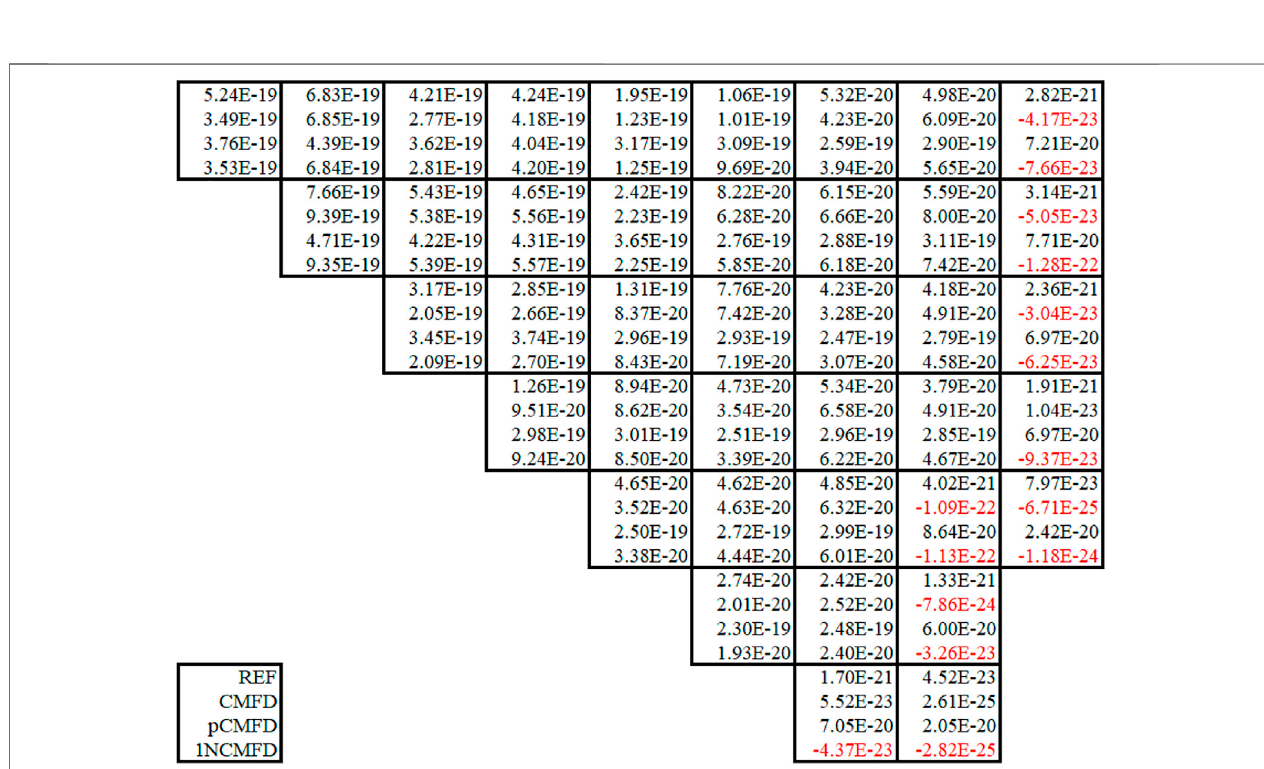
Frontiers in Energy Research |